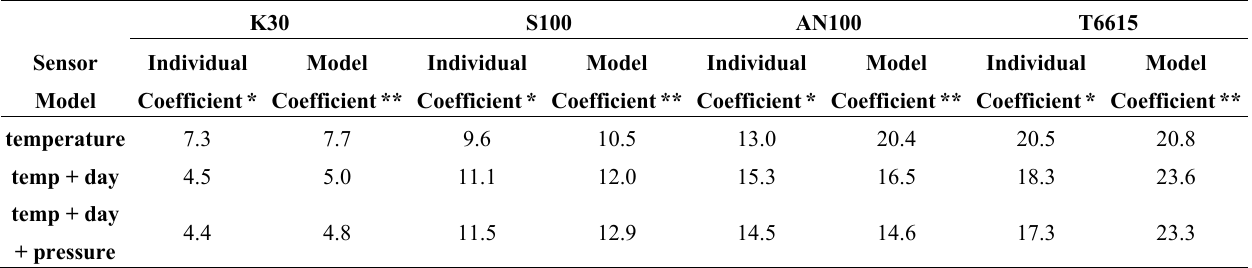
Table 2. Average RRMS errors using coefficients for temperature, length of use, and atmospheric pressure.